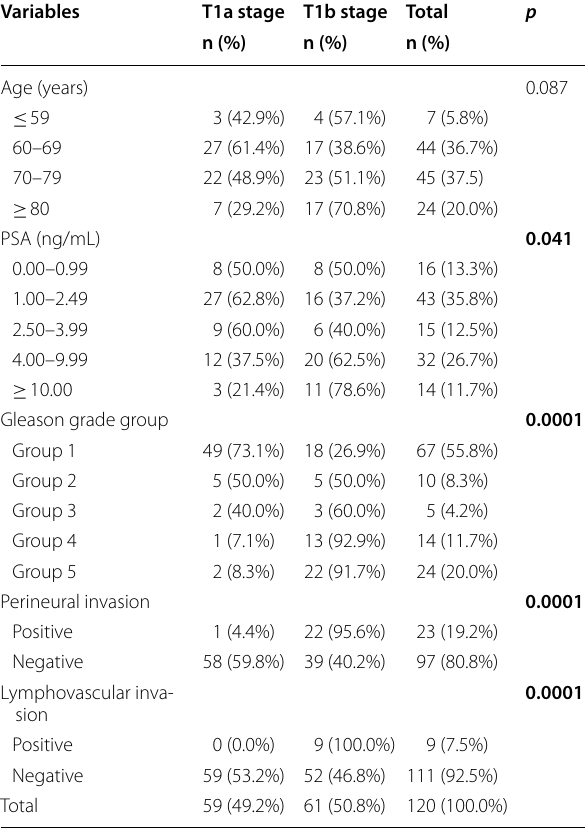
PSA prostate-specific antigen Bold values indicate statistical significance at the p < 0.05 level